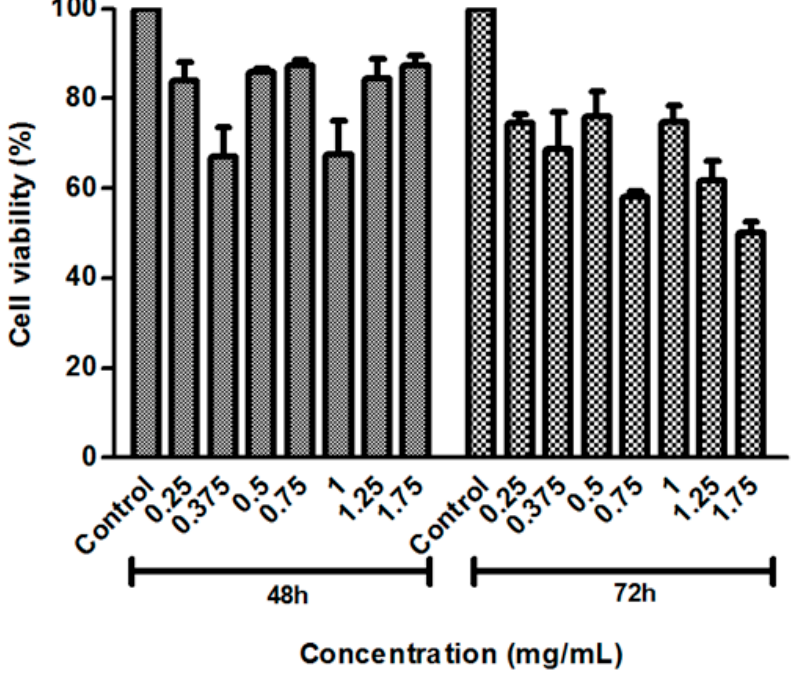
Figure 2. Effects of aqueous extracts from the leaves of Aspidosperma pyrifolium on 3T3 cell lines at concentrations from 0.25 to 1.75 mg/mL at 48 and 72 h.